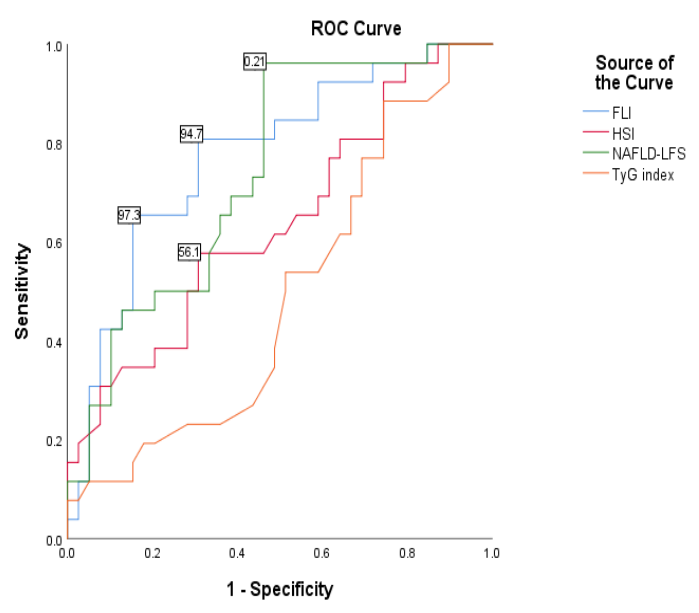
Figure 2. Receiver operating characteristic (ROC) curves for fatty liver index (FLI), hepatic steatosis index (HIS), NAFLD-liver fat score (NAFLD-LFS), and triglyceride and glucose index (TyG) in patients with type 2 diabetes.